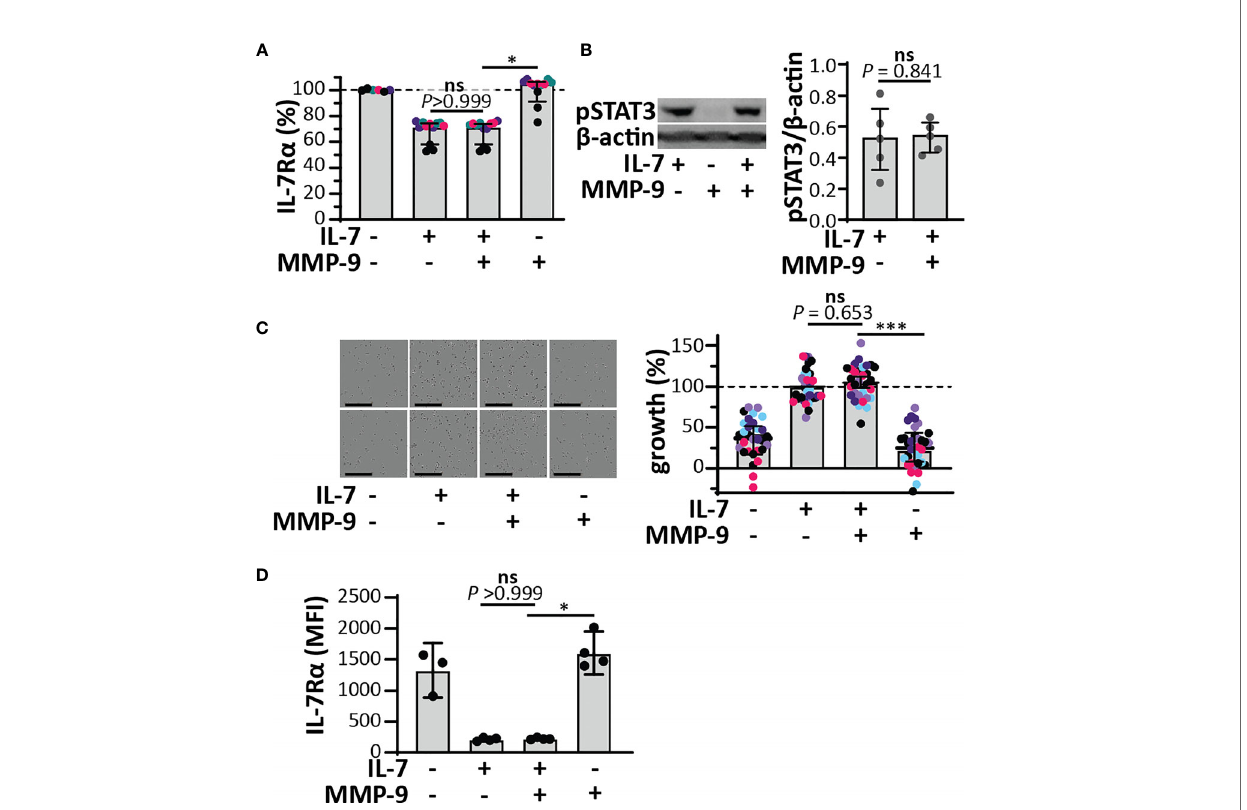
FIGURE 3 | Functional effects of IL-7 and IL-7-receptor internalization in HPB-ALL cells and human CD8 + PBMCs remain intact upon cleavage by MMP-9. (A) Analysis of cell-surface IL-7R, 5 minutes after stimulation of HPB-ALL cells with 50 ng/ml IL-7, cIL-7 (1/100 molar ratio MMP-9/IL-7, 4h at 37°C) or the equivalent of MMP-9. Data represent four independent experiments, with experimental replicates shown in the same color. Histograms represent median values and error bars represent the IQR. Data were normalized to the unstimulated condition, representing steady-state quantities of cell surface IL-7R (100% IL-7R a ). *p<0.05, as determined by Kruskal-Wallis test with Dunn ’ s correction for multiple comparisons and calculated on mean values of each experiment. (B) Analysis of pSTAT3 (Tyr 705 ) in HPB-ALL cells, 15 minutes after stimulation with 50 ng/ml IL-7, cIL-7 (1/100 molar ratio MMP-9/IL-7, 4h at 37°C) or the equivalent of MMP-9. Each data point indicates an independent experiment. Histograms represent median values and error bars represent the IQR. Data were normalized to b -actin. (C) Growth of HBP-ALL cells, 4 days upon stimulation with 50 ng/ml IL-7, cIL-7 (1/100 molar ratio MMP-9/IL-7, 4h at 37°C) or the equivalent of MMP-9 (right panel). Data represent six independent experiments, with all experimental replicates shown in the same color. Histograms represent medians and error bars represent the IQR. Data were normalized to cells stimulated with IL-7 alone, representing 100% growth. ***p ≤ 0.001, as determined by Kruskal-Wallis test with Dunn ’ s correction for multiple comparisons and calculated on the mean values of each experiment. (Left panel) representative images of HPB-ALL cells with the indicated stimulations. Scale bar = 200 µm. (D) Analysis of cell-surface IL-7R, 24h after stimulation of human CD8 + PBMCs with 15 ng/ml IL-7, cIL-7 (1/100 molar ratio MMP-9/IL-7, 4h at 37°C) or the equivalent of MMP-9. Histograms represent median values and error bars represent the IQR. *p<0.05, as determined by Kruskal-Wallis test with Dunn ’ s correction for multiple comparisons. ns, not signi fi